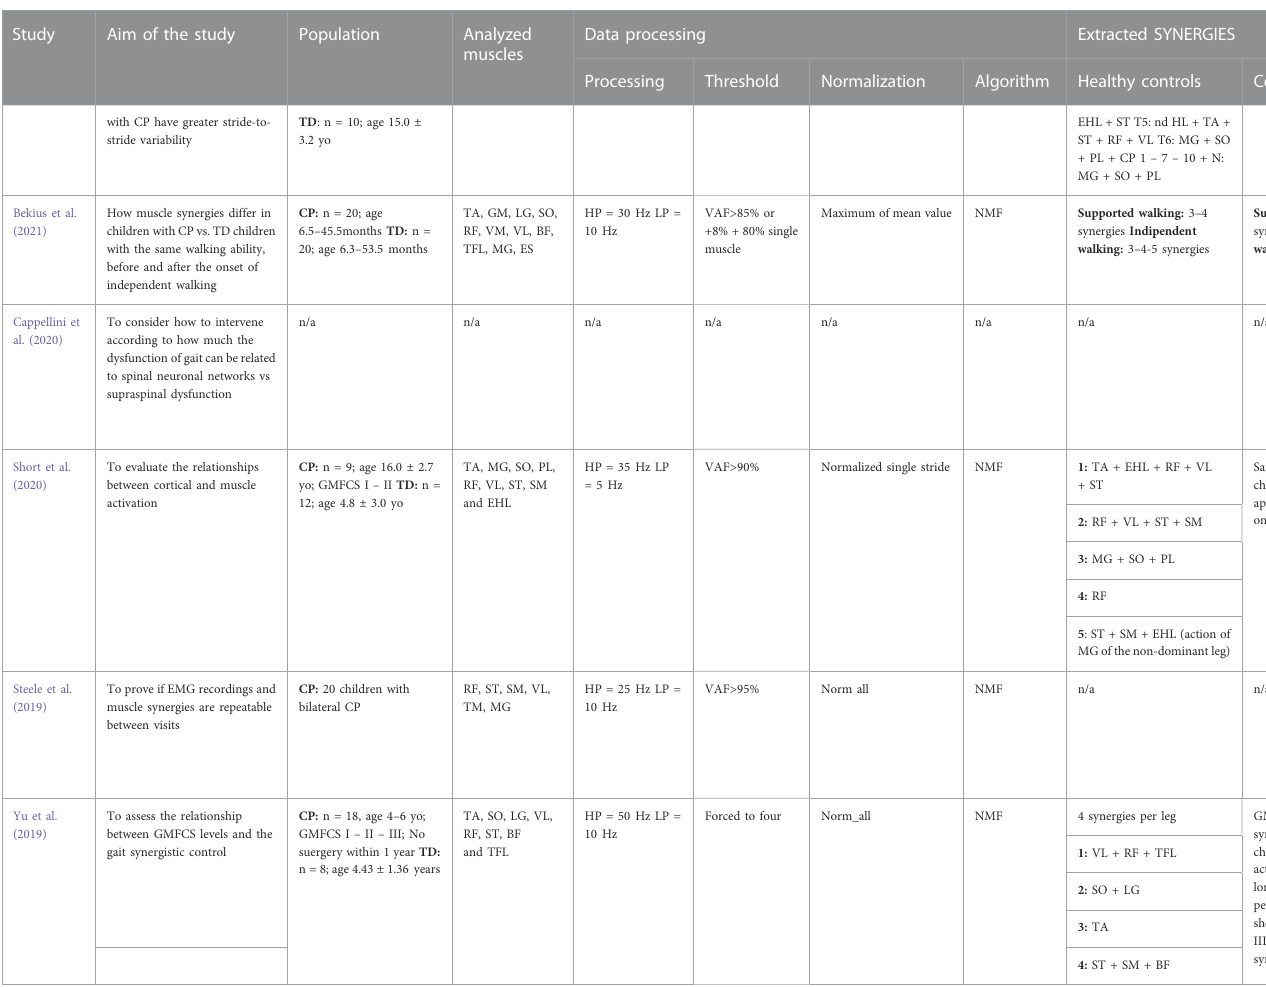
TABLE 1 ( Continued ) Aim of the study, population, analyzed muscles, data processing, data structure, extracted synergies, main results of the articles investigating how muscle synergies vary in children affected by Cerebral Palsy (CP) in respect to healthy subjects. Acronyms: CP: cerebral palsy, TD: typically developed, HC: healthy controls, GMFCS: Gross Motor Function Classi fi cation System, BW: backward walking, FW: forward walking,